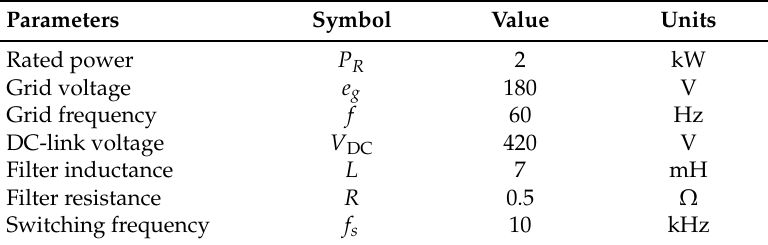
Figure 3. The whole system configuration for simulation. Table 1. System parameters of grid-connected inverter. Table 1. System parameters of grid-connected inverter.